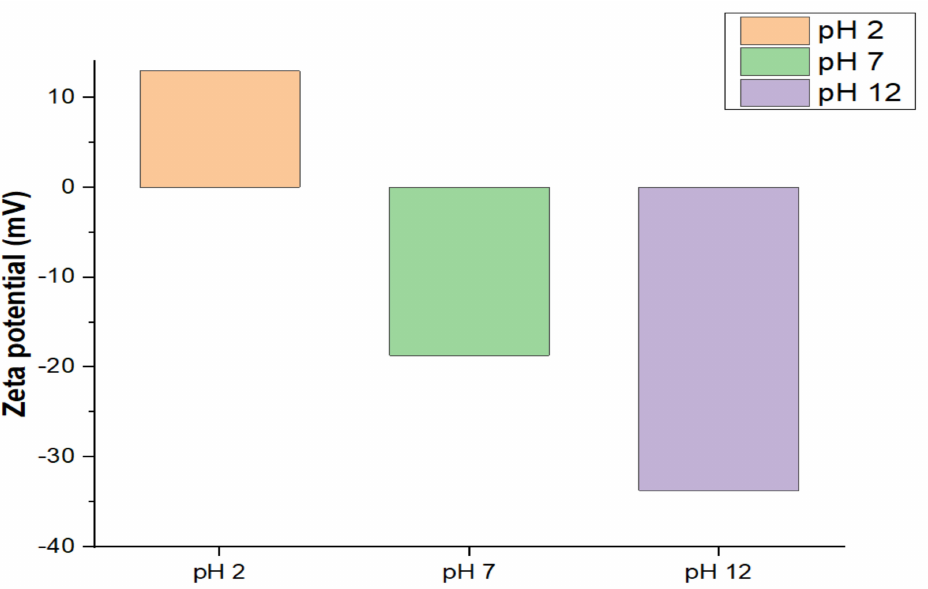
Figure 7. Zeta potential of Cu 3.21 Bi 4.79 S 9 /gC 3 N 4 at pH 2, 7, and